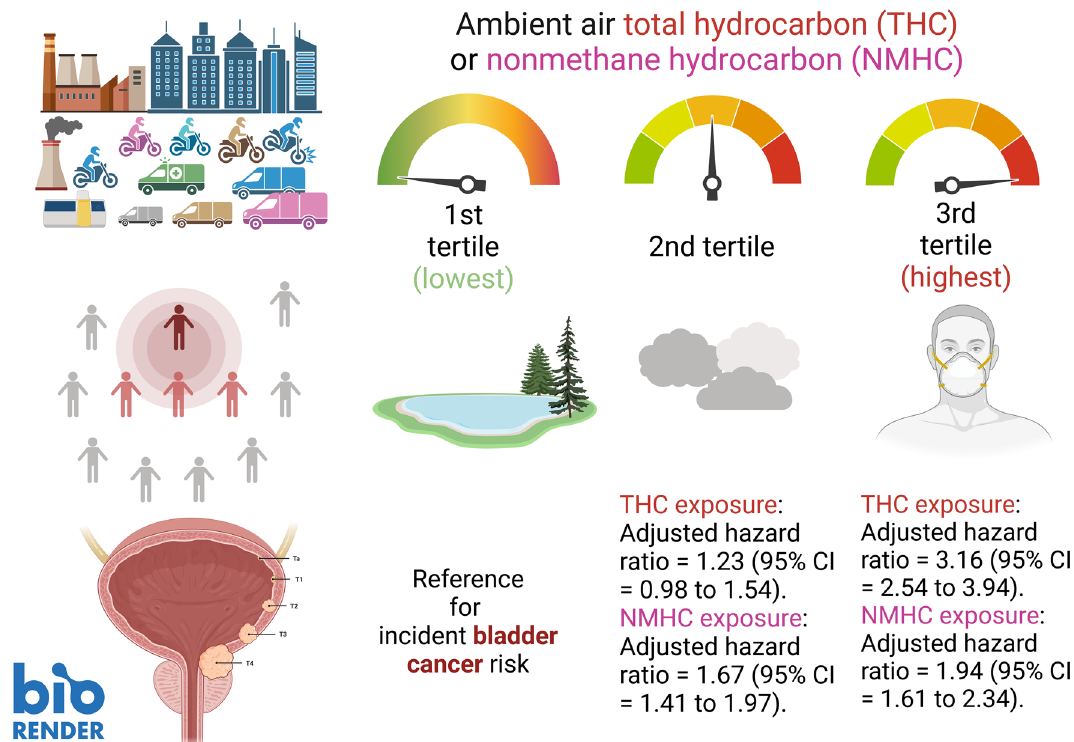
Figure 3. A schematic diagram summarizing the study results of the risk of developing urinary bladder cancer associated with long-term exposure to different tertiles of airborne THC or NMHC concentration. The magnitudes of risk show a significant exposure–response